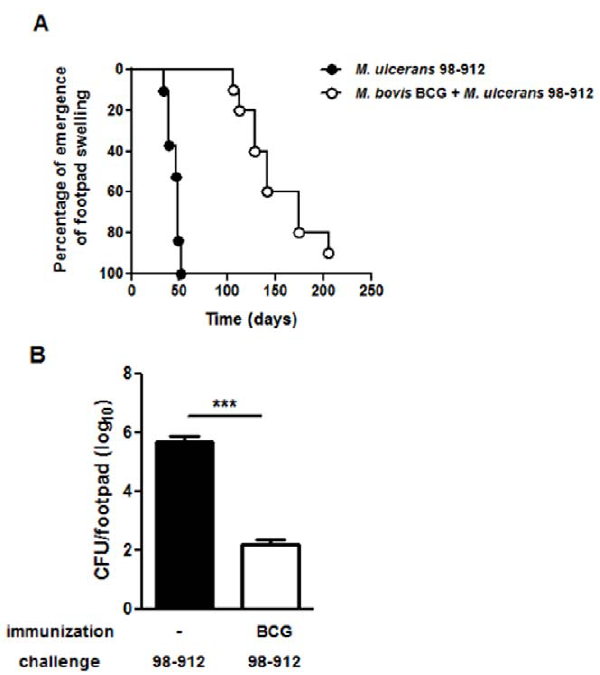
Figure 1. Immunization with BCG delays the onset of footpad N swelling and reduces bacillary growth in M.ulcerans infected ) or immunized with BCG mice. Mice were either non-immunized ( ( # ) two months before challenge. All mice were infected in the footpad with 4 log 10 CFU of M. ulcerans 98–912. (A) Footpad swelling was monitored throughout the experimental infection ( n =10). The onset of footpad swelling was considered at 2.60 mm, after which mice progressed to ulceration of the footpad. For ethical reasons, mice were sacrificed upon onset of footpad ulceration. (B) Infected footpads of BCG immunized mice (white bar) or non-immunized mice (black bar) were harvested at day 52 post-infection and processed for CFU count. Bars represent the mean 6 SEM ( n =5) log 10 CFU/footpad.